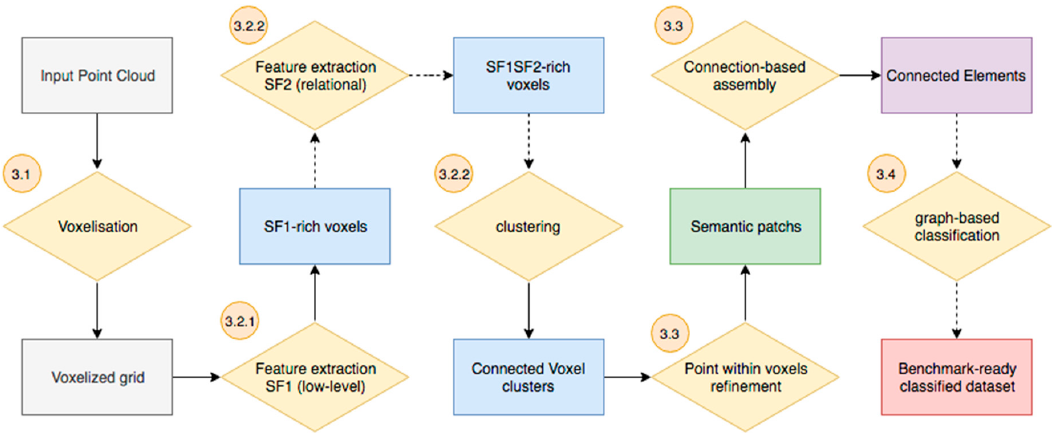
Figure 3: Methodological workflow for the constitution of Connected Elements and knowledge-based classification. A point cloud goes through seven serialized steps (diamonds) to obtain a fully classified dataset (red square).